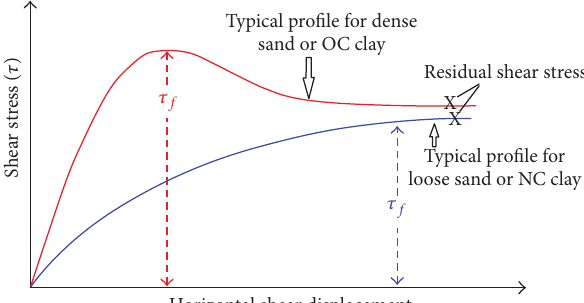
F 1: Typical shear stress versus horizontal shear displacement (OC stands for overconsolidated and NC stands for normally consolidated).